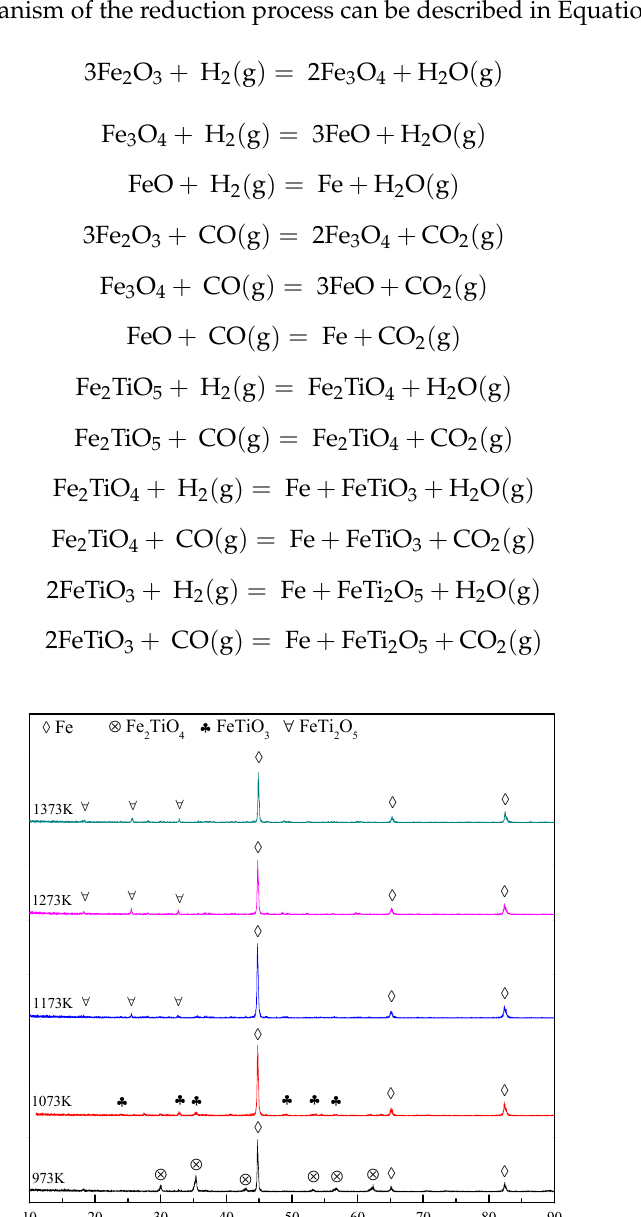
Figure 5. Plot of 1 − (1 − (cid:1844)) (cid:3117) (cid:3119) vs. time ( a ) and plot of 1 − (cid:2870) (cid:2871) (cid:1844) − (1 − (cid:1844)) (cid:3118) (cid:3119) vs. time ( b ) at 973 K–1373 K in H 2 /(H 2 + CO) = 1/2 atmosphere.